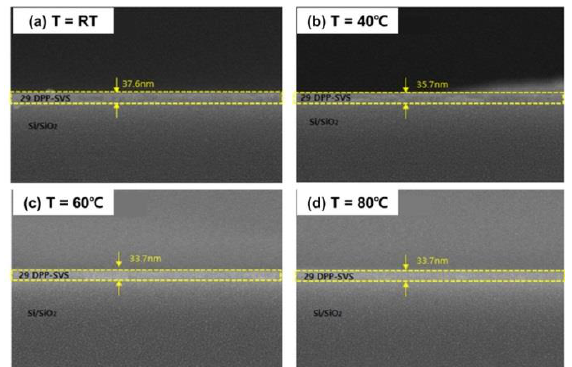
Figure 2. Cross-sectional field emission scanning electron microscopy (FE-SEM) images of 29-DPP-SVS polymer films blade-coated with substrate temperature at ( a ) RT, ( b ) 40 °C, ( c ) 60 °C, and ( d ) 80 °C.